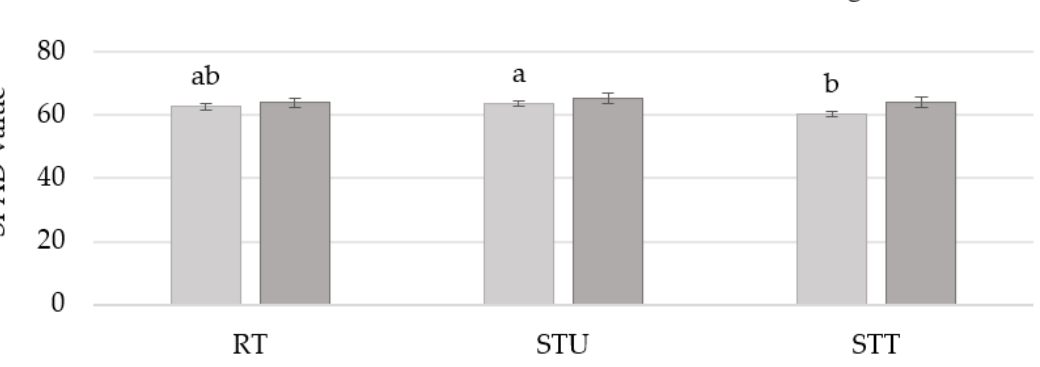
1 RT = rototilling, STU = strip till + untreated, STT = strip till + treated; 2 RG = perennial ryegrass, WC-F = white clover—sown in fall, WC-S = white clover—sown in spring, MC-F = micro clover—sown in fall, MC-S = micro clover—sown in spring.